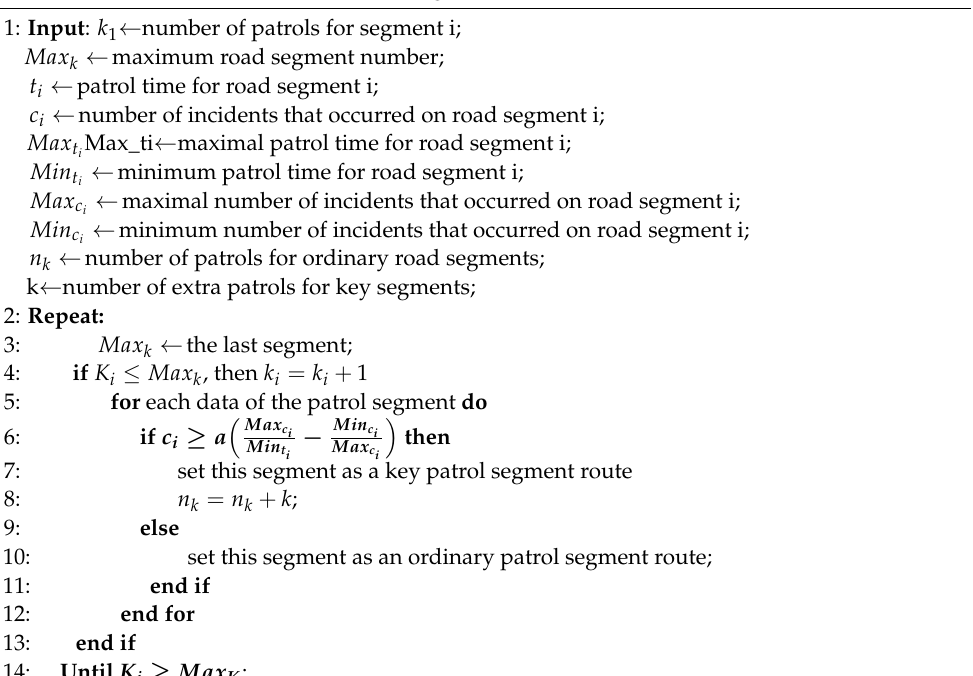
Algorithm 1: Patrol Route Classification